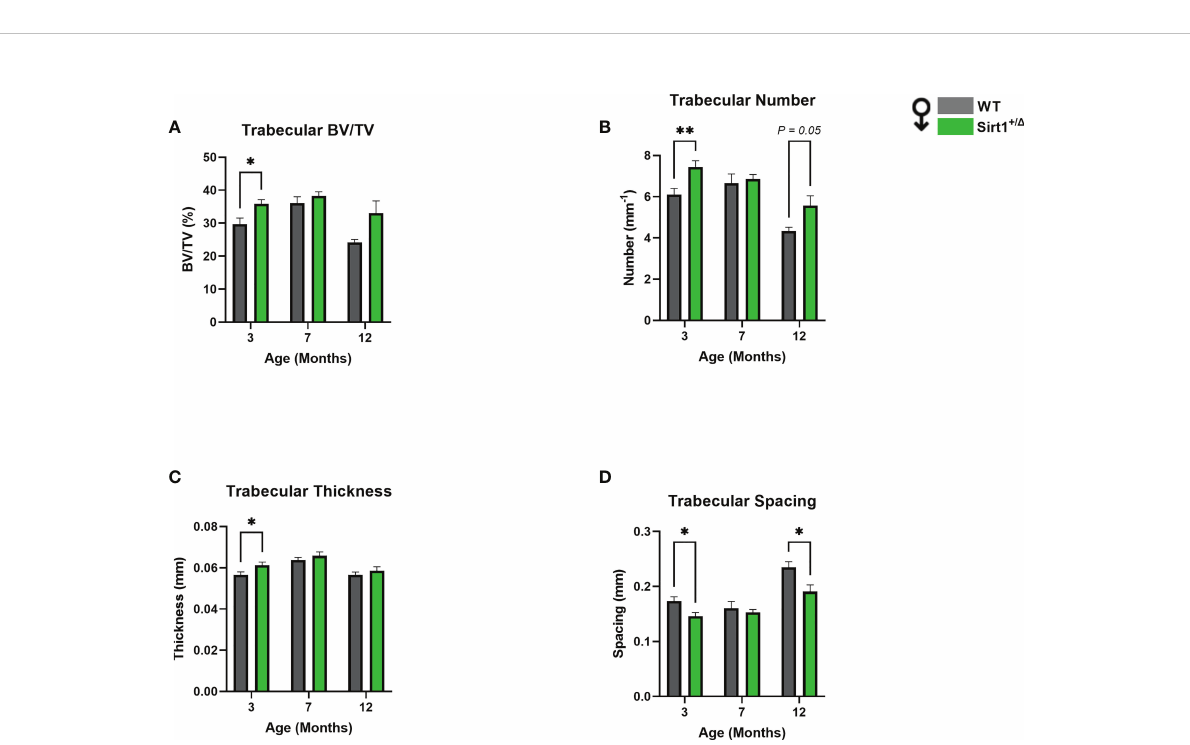
FIGURE 4 Sirt1 haploinsuf fi ciency leads to increased vertebral L4 trabecular bone indices in Sirt1 +/ D male mice. µCT analysis of L4 trabecular bone: (A) Bone volume fraction (BV/TV%) (B) Trabecular number (C) Trabecular thickness (D) Trabecular spacing. Results are Mean ± SEM analyzed by unpaired Student ’ s t test; * P < 0.05, ** P < 0.01 versus WT male mice (n = 7-11